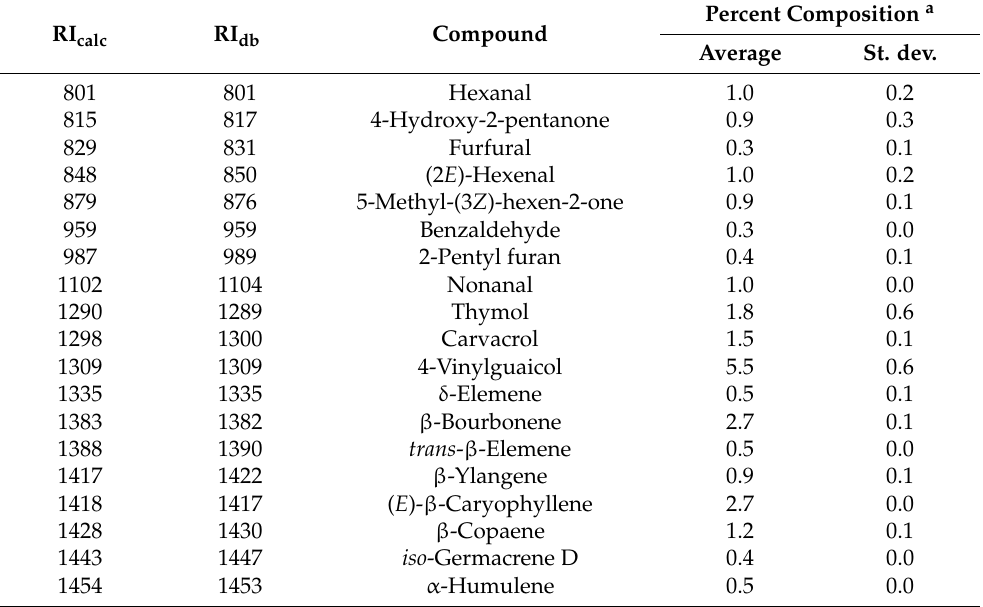
Table 4. Essential oil composition of early sunflower ( Heliopsis helianthoides ) cultivated in southern